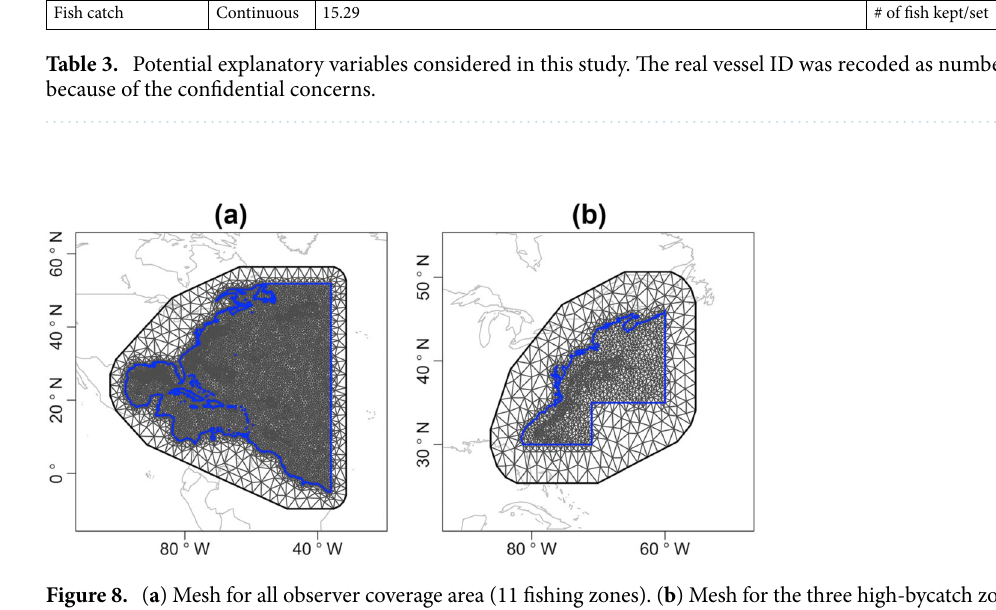
Figure 8. ( a ) Mesh for all observer coverage area (11 fishing zones). ( b ) Mesh for the three high-bycatch zones. The blue line is the domain boundary. The SPDE edge effect is moved outside the domain of interest using an extension with larger triangles. Plot is made in statistical program R (version 3.6.3, http:// www.R- proje ct. org/). Map data is from R package maps (version 3.3.0, https:// CRAN.R- proje ct. org/ packa ge=